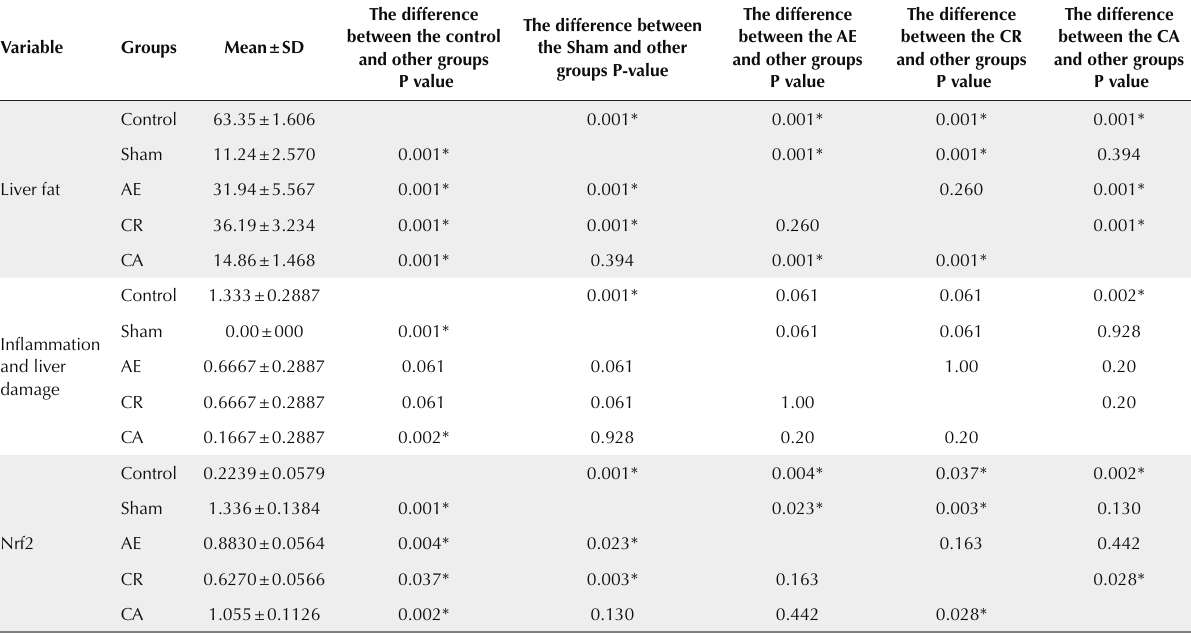
Table 2. Comparison of liver fat, inflammation, damage, and relative expression of Nrf2 protein between the AE, CR, and CA groups Variable Groups Mean ± SD